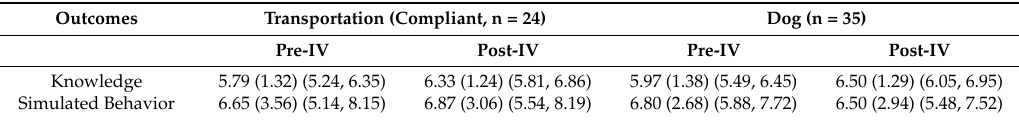
Table 3. Mean (standard deviation) and 95% confidence interval for outcome variables across groups.